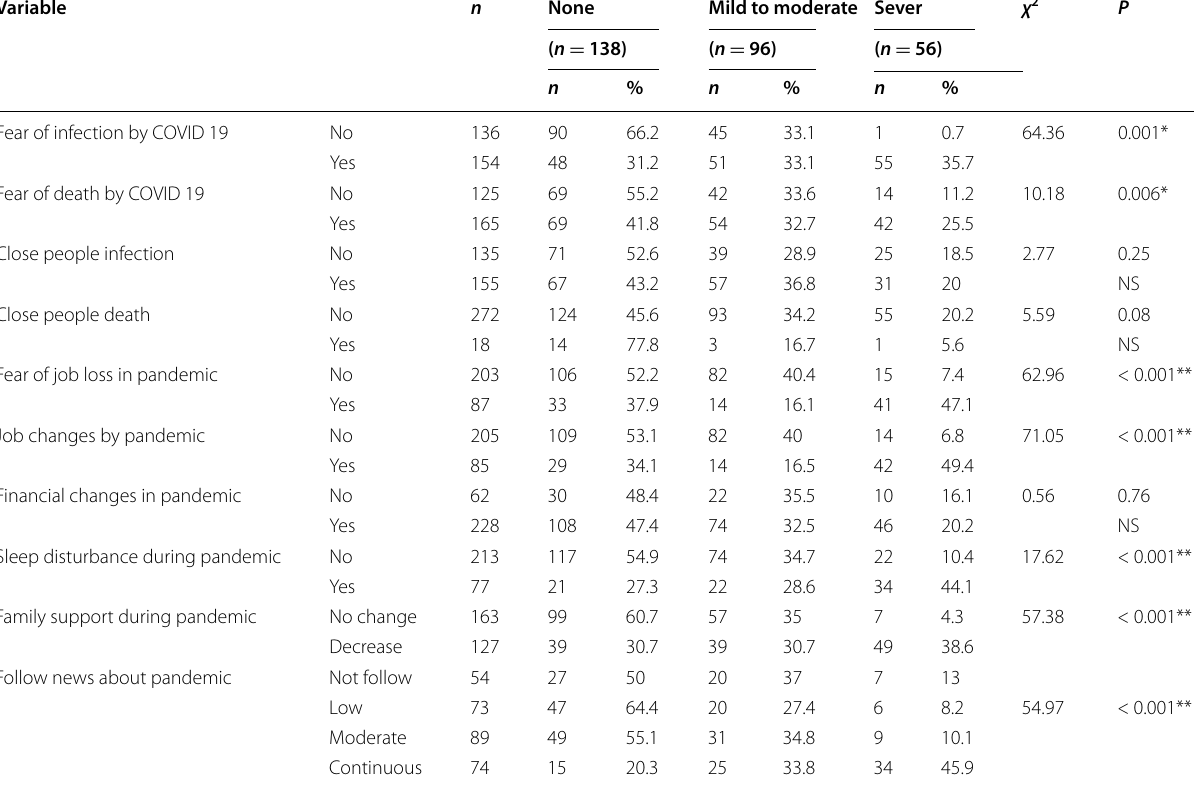
Table 4 The relationship between anxiety and